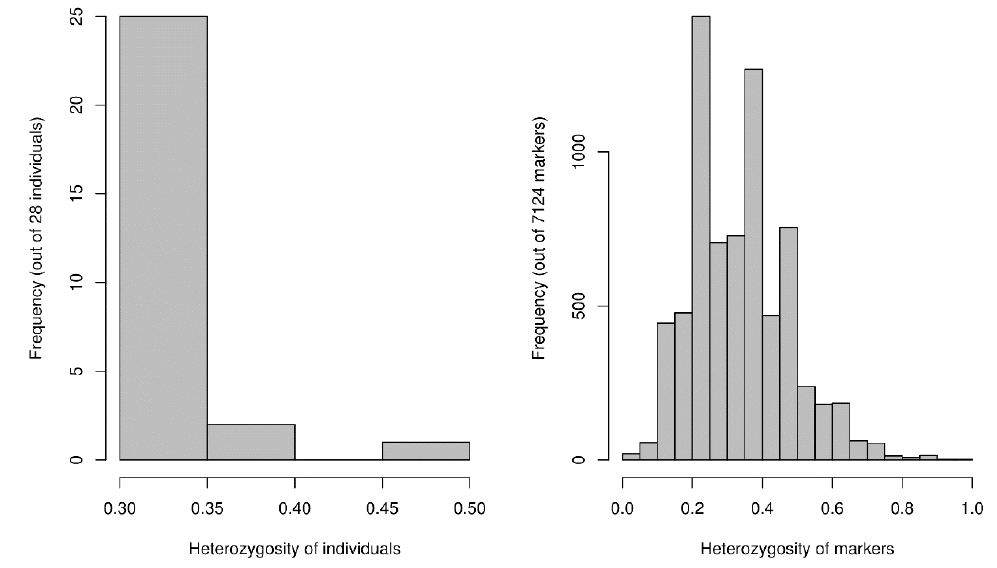
Figure 2. Frequency of heterozygous genotypes and heterozygosity of 7125 SNP markers. In contrast, pairwise genetic structure does however show differentiation between pairwise population comparisons (Table 3). Pairwise F ST θ estimates ranged from 0.0021 (non-resistant population versus Cry3Bb1 resistant population) to 0.0531 (Cry34/35Ab1 resistant population versus Cry3Bb1_Cry34/35Ab1 resistant population). Cry34/35Ab1 and Cry3Bb1_Cry34/35Ab1 populations showed the greatest genetic differentiation with respect to all other